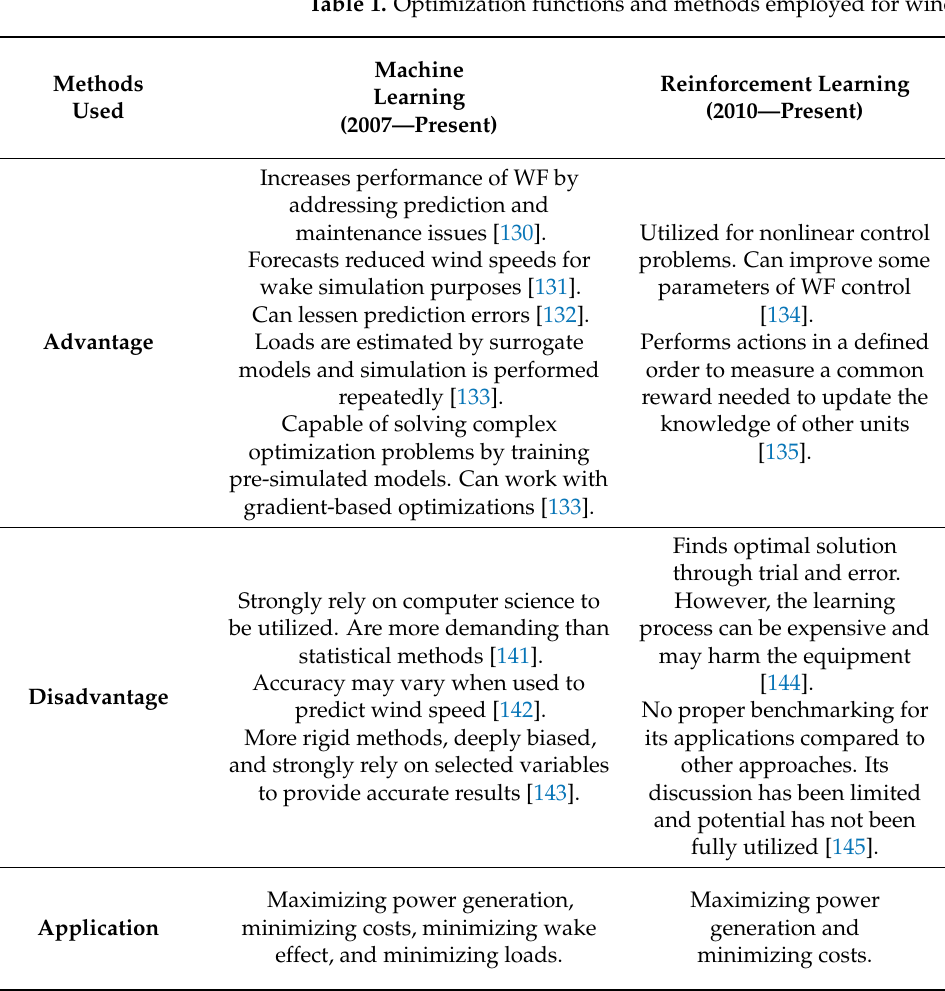
Table 1. Optimization functions and methods employed for wind farm